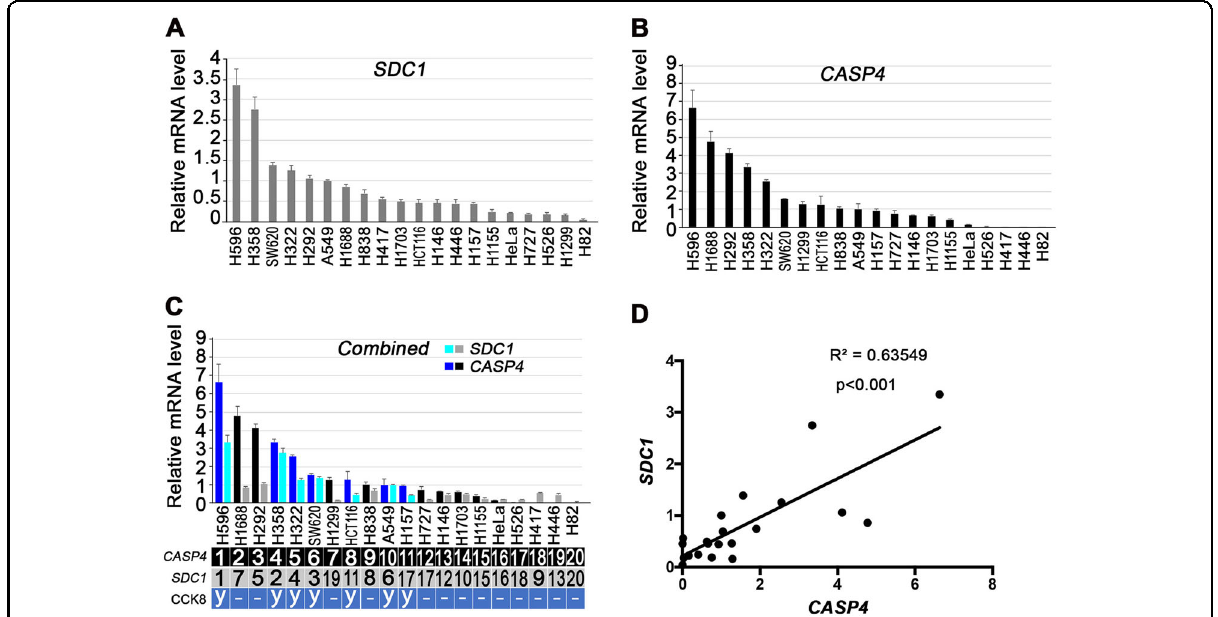
Fig. 1 Evaluation of the susceptibility to SCGB3A2-LPS and expression analysis of SDC1 and CASP4 in various human cancer cells. A , B qPCR quanti fi cation of the relative expression levels for SDC1 ( A ) and CASP4 mRNA ( B ) in various human malignant cells. The expression level in A549 cells was arbitrarily set as 1.0. Graphs are representative of three independent experiments, each done in triplicate. C Combined qPCR results of A and B . Ranked order for CASP4 and SDC1 mRNA expression is indicated in the order from the highest to lowest, shown underneath the graph. The susceptibility to SCGB3A2 + LPS determined by CCK8 assay is shown as “ y (observed) ” or “– (not observed) “ in the CCK8 row. A bar for CASP4 and SDC1 mRNA of those susceptible to SCGB3A2 + LPS is indicated by dark blue ( CASP4 ) and light blue ( SDC1 ), respectively. D Correlation graph between SDC1 and CASP4 mRNA levels in 20 human cancer cells. Pearson correlation r = 0.7988, P < 0.